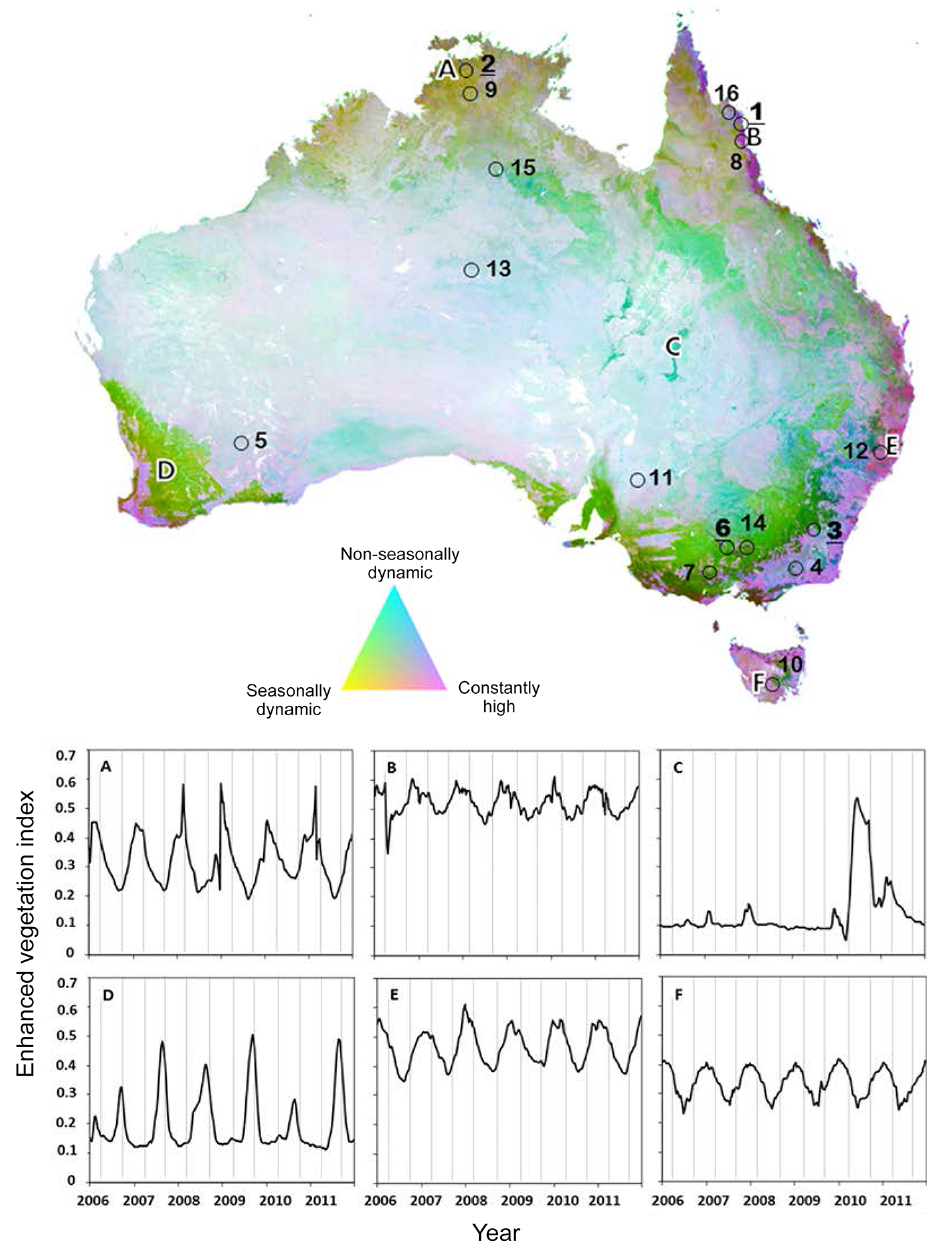
Figure 2. Enhanced vegetation index (EVI) map of Australia obtained from MODIS global 0.05 ◦ 8-day reflectance composites for 2000– 2012 (MOD09) with a selection of six pixels to demonstrate the following. Yellow areas have a strong seasonal cycle, such as Howard Springs at point A. Cyan areas have relatively strong but non-seasonal variations in EVI, such as Channel Country at point C. Magenta areas have a more constant moderate to high EVI with less temporal variability compared with other sites, which include sites such as Cape Tribulation at point B, the central coast at point E and the Tasmanian highlands at point F. Green areas have both seasonal and non-seasonal variation, such as the wheat belt of Western Australia at point D. Blue areas have relatively high greenness but strong non-seasonal variation. The paler colours of the map centre show weaker EVI signals. The SD in seasonally adjusted anomalies (yellow) was scaled from 0 to 0.1; SD in mean seasonal cycle (cyan) from 0 to 0.1; and mean EVI (magenta) from 0 to 0.6. Also included are the locations (and Fluxnet codes where applicable) of currently operating phenocams in Australia. Numbers refer to 1. Cow Bay (AU-Cow); 2. Howard Springs (AU-How); 3. Tumbarumba (AU-Tum); 4. Karawatha; 5. Great Western Woodlands (AU-GWW); 6. Whroo (AU-Whr); 7. Wombat (AU-Wom); 8. Robson Creek (AU-Rob); 9. Litchfield (AU-Lit); 10. Warra (AU-Wrr); 11. Calperum (AU-Cpr); 12. Cumberland Plain (AU-Cum) and EucFACE; 13. Alice Springs (AU-ASM); 14. Riggs Creek (AU-Rig); 15. Sturt Plains (AU-Stp); 16. Cape Tribulation (AU-Ctr). Phenocam data used in this paper are from sites 1, 2, 3, and